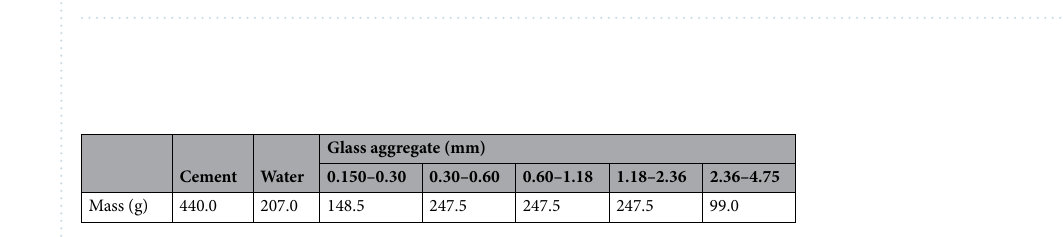
Table 1. Nano-scale mechanical parameters of the ASR products examined by nanoindentation tests. Note: SD denotes the standard deviation.